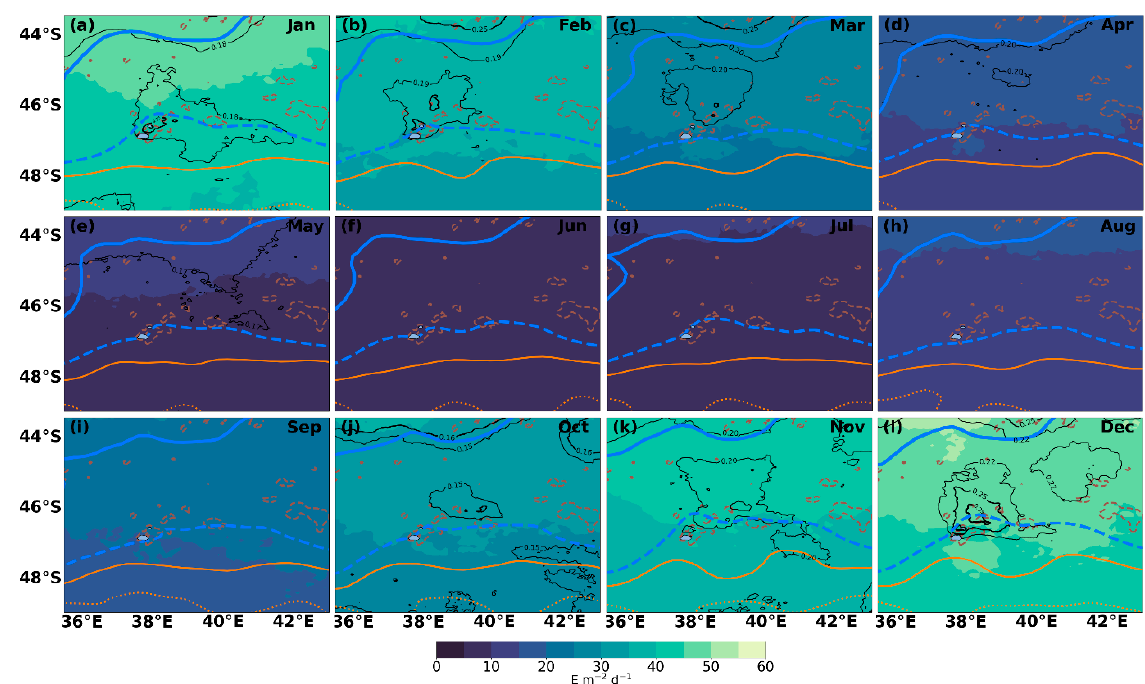
Figure 4. ( a – l ) Monthly (January to December) climatology (1997–2020) of SeaWiFS and MODIS Aqua Photosynthetically Available Radiation (PAR; E m − 2 d − 1 ). The black contours indicate the lowest and highest chla (mg m − 3 ) concentrations that formed unique closed contours in our region of interest (0.18 and 0.25 in January; 0.19 and 0.25 in February; 0.20 and 0.25 in March; 0.20 in April; 0.17 in May; 0.15 and 0.16 in October; 0.20 and 0.25 in November; 0.22, 0.25, and 0.29 in December). The dashed brown contours indicate the 1000 m isobath. The solid and dashed thick blue lines show the climatological mean positions of the middle (M-SAF) and southern (S-SAF) branches of the sub-Antarctic Front, respectively. The solid and dotted thick orange lines illustrate the climatological mean positions of the northern (N-APF) and middle (M-APF) branches of the Antarctic Polar Front, respectively.